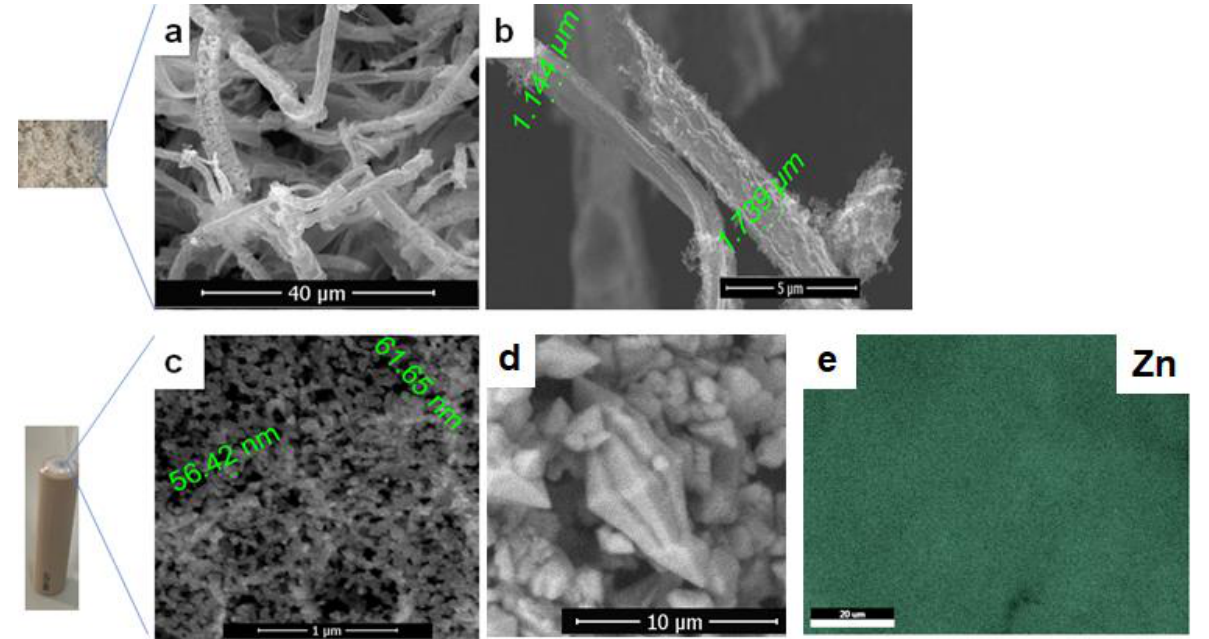
Figure 1. SEM images of obtained ZnO nanostructures ( a , b ) and modified GC/Nafion ZnO 6 electrode ( c , d ). EDS mapping of Zn from GC/Nafion ZnO 6 electrode ( e ).